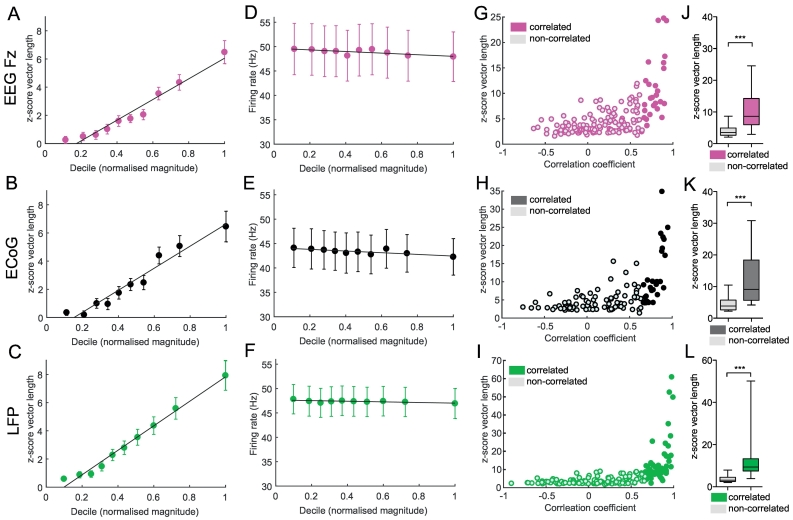
Linear entrainment of STN units to population beta oscillations. A-C, Group average of phase-locking strength (z-score vector length) along the mean normalised magnitude in each decile (x-axis). Error bars show +/− SEM. Group means consist only of magnitude-correlated units for a given signal (Fz: n = 28/154 (A), ECoG: n = 27/109 (B) and LFP: n = 56/172 (C)). The line shows the linear fit of the group average with a significant correlation for all population oscillation signals (Fz: R = 0.96, p = 3.35e-05; ECoG: R = 0.98, p = 1.23e-06; LFP: R = 1, p = 2.67e-09). D-F, Group average of the firing rate +/− SEM in each decile along the mean normalised magnitude in each decile (x-axis) for Fz (D), EcoG (E) and LFP (F). Group averages were limited to consist of the same magnitude-correlated units as in A-C. Note that the majority of units show no correlation between the magnitude deciles and the firing rate (see text) and the mean firing rate remained stable across the deciles. G-I, Z-score vector length of each recording plotted against the Pearson‘s correlation coefficients for magnitude-correlation (i.e. the line in A-C now for each unit-field pair). Hollow points represent the non-significantly correlated units and filled dots represent magnitude-correlated units. Note the positive correlation between the correlation coefficients (mean normalised magnitude decile x z-score vector length) and the overall phase-locking strength of the entire recording (Fz: n = 154, Pearson's R = 0.57, p = 4.71e-15; ECoG: n = 109, Pearson's R = 0.55, p = 8.67e-10; LFP: n = 172, Pearson's R = 0.51, p = 6.99e-13). J-L, Statistical comparison (MWUT) of the z-score vector length between non-correlated and magnitude-correlated units revealed a significant higher phase-locking strength for magnitude-correlated units to all population oscillations (Fz (J), EcoG (K) and LFP (L)). This indicates that units that display increasing phase-locking strength with increasing EEG/ECoG/LFP beta oscillation strength (magnitude) over time, have a higher overall phase-locking strength (are more strongly phase-locked during the entire recording). *** p < 0.001, box plot whiskers show 5-95th percentile. Additional analyses on the relationship between spike train oscillation power, phase-locking strength and the correlation strength between phase-locking and population oscillation magnitude are shown in Supplementary Fig. 3. Note that for all analyses in this figure the preferred beta-frequency of phase-locking was chosen for each unit-population oscillation pair. A distribution of preferred beta-frequencies is shown in Supplementary Fig. 4 and did not differ between cortical and subcortical signals or oscillatory neuron groups.